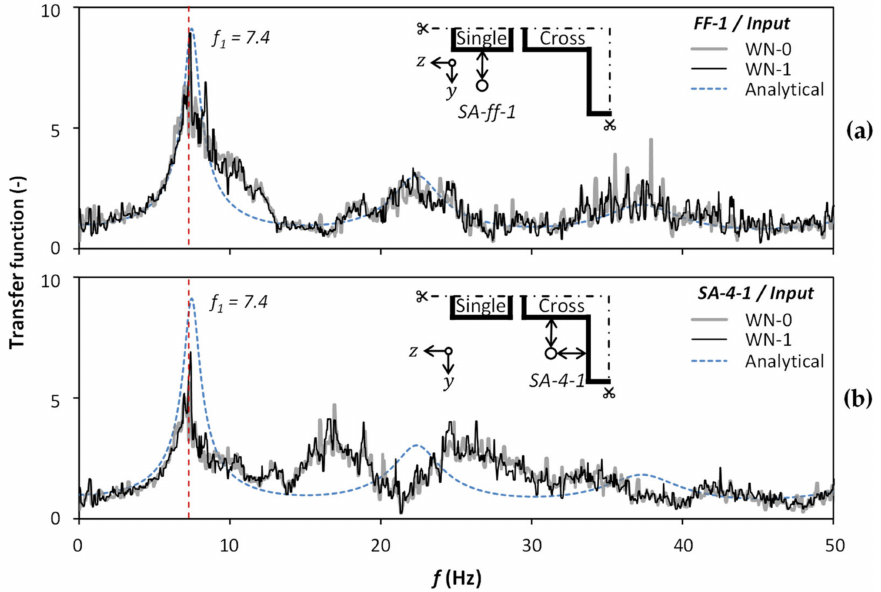
Figure 13. Comparison of the transfer function during the white noise motions before and after tests, along with the analytical results with 7% damping ( a ) in the accelerometer array out of the single station (SA-ff) and ( b ) in the accelerometer array out of cross interchange station